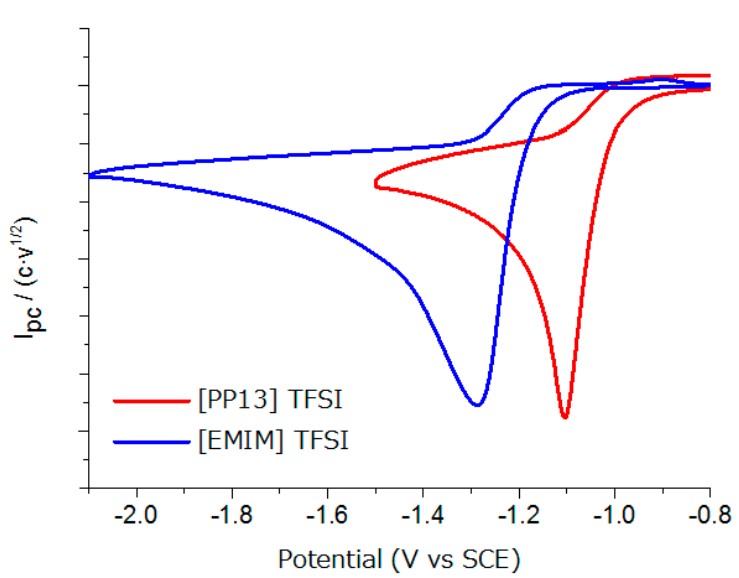
Figure 2. Cyclic voltammograms of a 5 mL solution, [PP13]TFSI (red line) and [EMIM]TFSI (blue line), containing 10 mM 4-iodobenzonitrile using Ag under a nitrogen atmosphere. Scan rate 0.5 V s − 1 . Table 1. Electrochemical parameters for the electrochemical reduction of 1 .